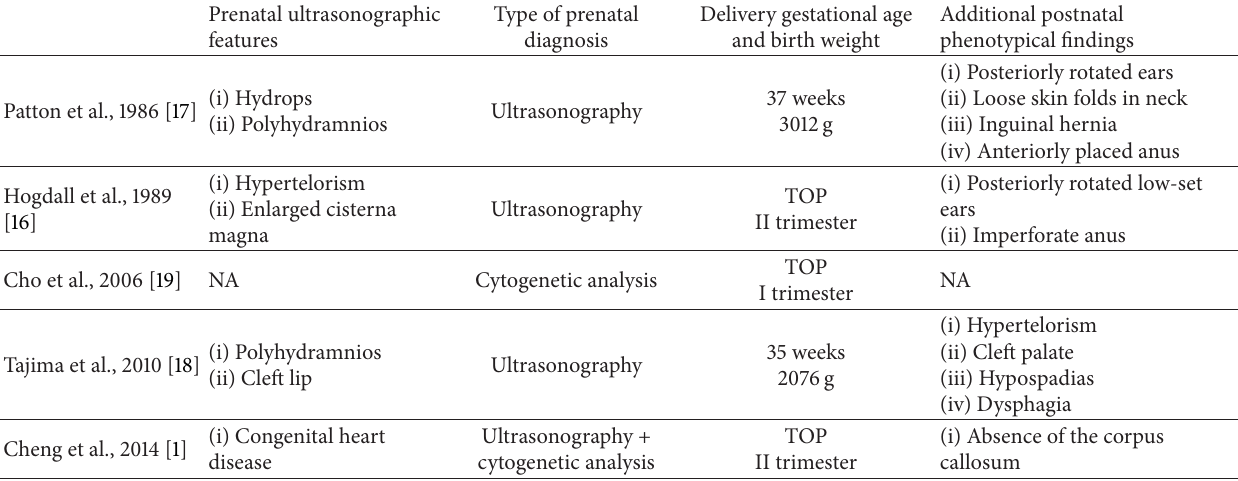
Table 1: List of reported cases of prenatally detected maternally inherited Opitz syndrome (modified from Cheng et al., 2014